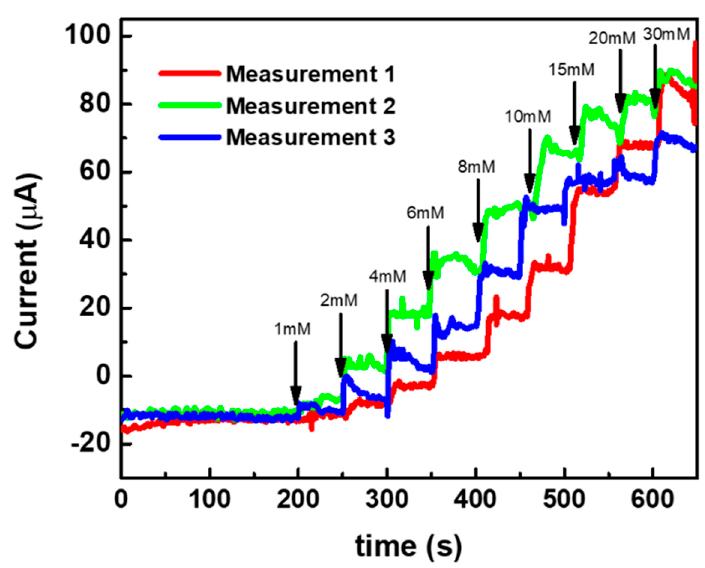
Figure 9. Response study of the sensor in ISF in a range of glucose concentration from 1 to 30